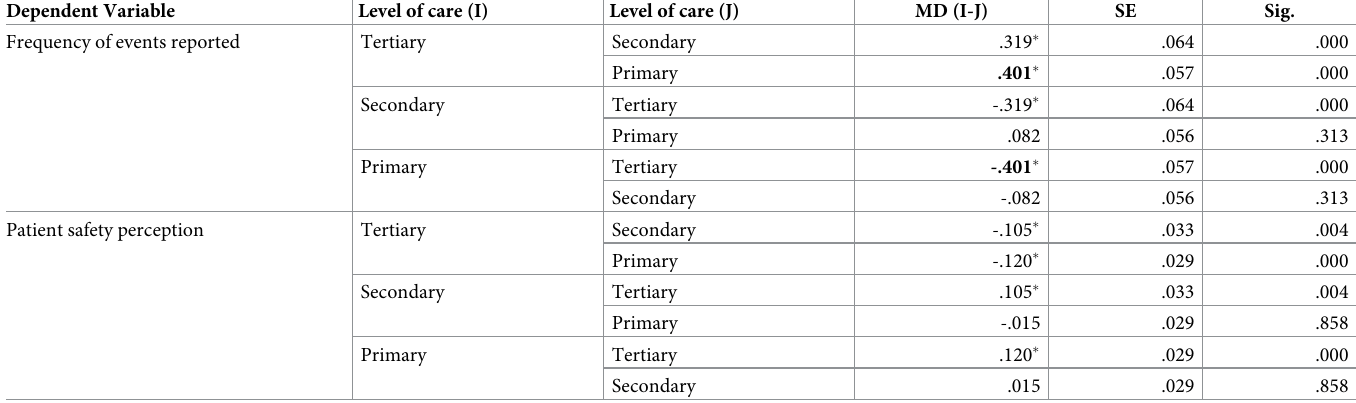
Table 4. Post-hoc Tukey HSD test.